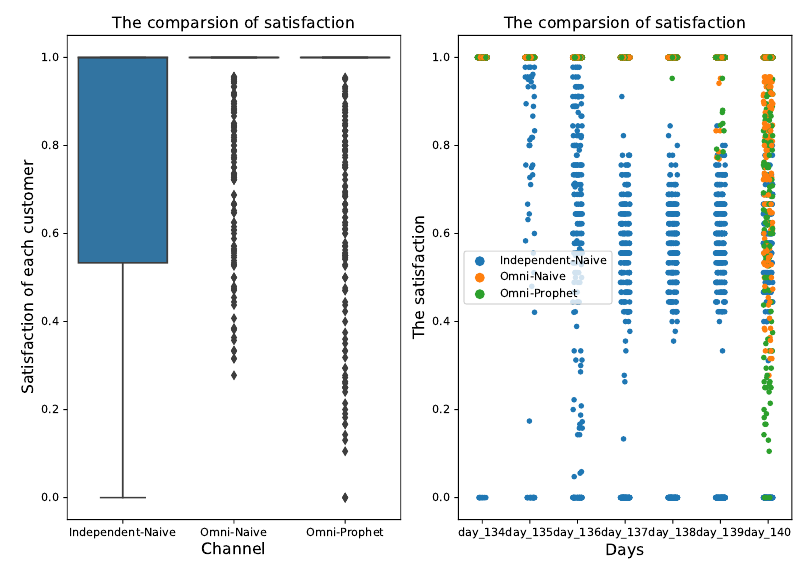
Figure 11. Customer satisfaction comparison in the scenario with increasing demand. Table 8. Performance comparison in the scenario with increasing demand. Independent-Nai Omni-Nai Omni-Prophet Cost Satisfaction Cost Satisfaction